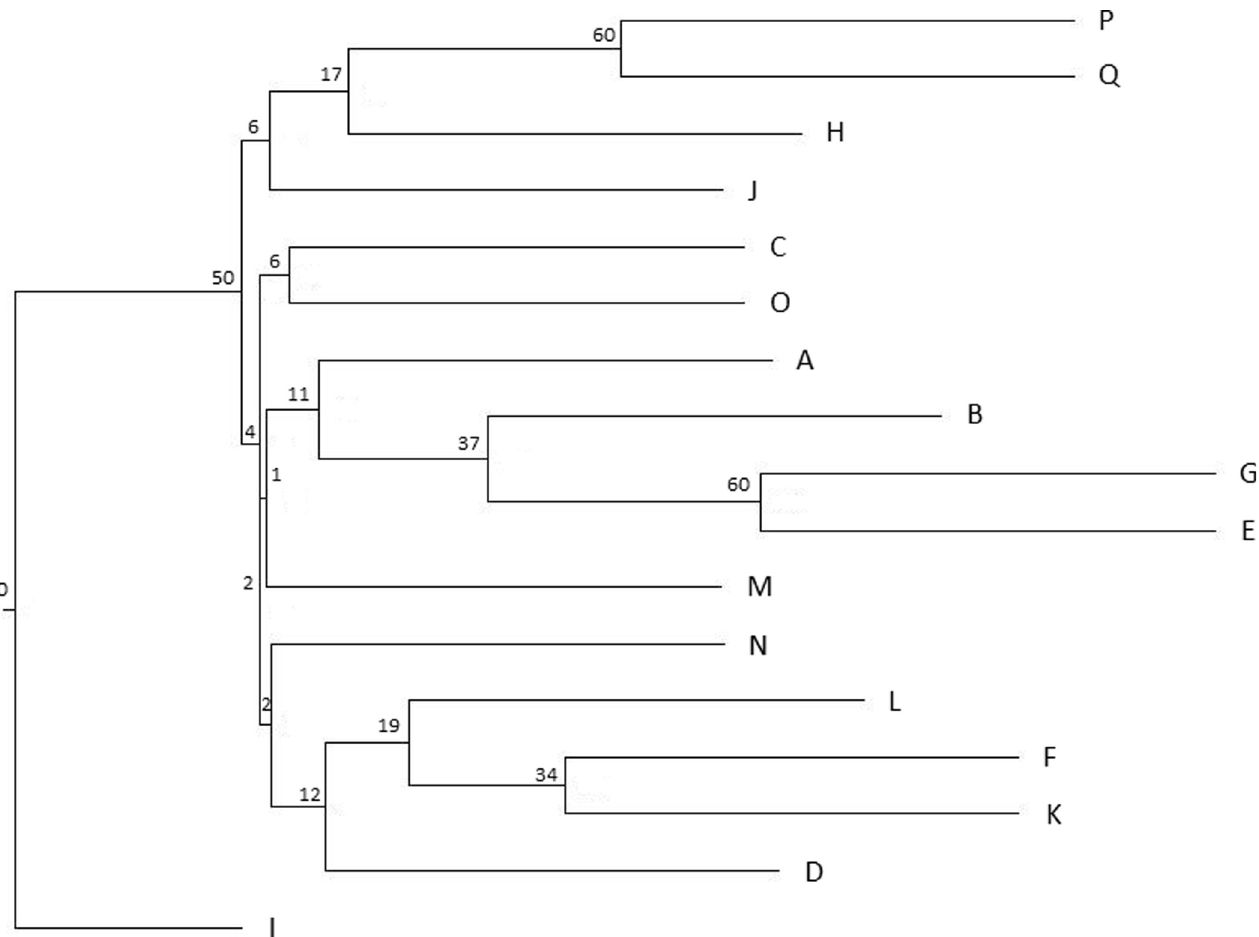
Fig 3. The neighbour-joining tree (NJT) for the French data set F partitioned into 17 watersheds (A-Q) following Douhovnikoff and Dodd [31] based on Nei’s genetic distance ([47] after [48]) calculated using 12 nuclear SSR markers. Watersheds from A to Q are distributed from north to south in central California (see also Fig 1 and S1 Table). Bootstrap values are presented as